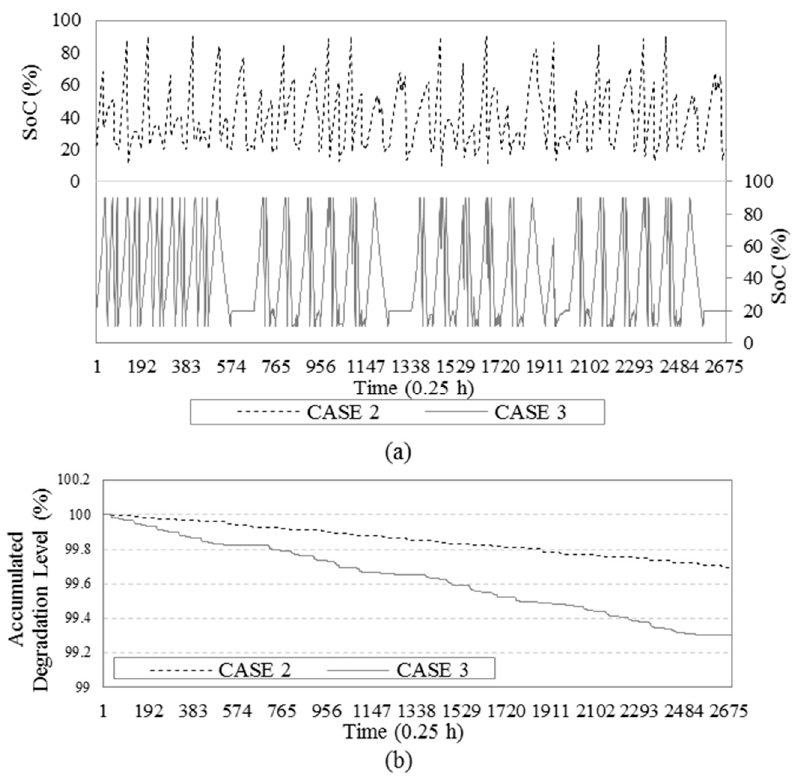
Figure 6. Impact of operation strategies on degradation by case: ( a ) SoC, and ( b ) accumulated degradation level.